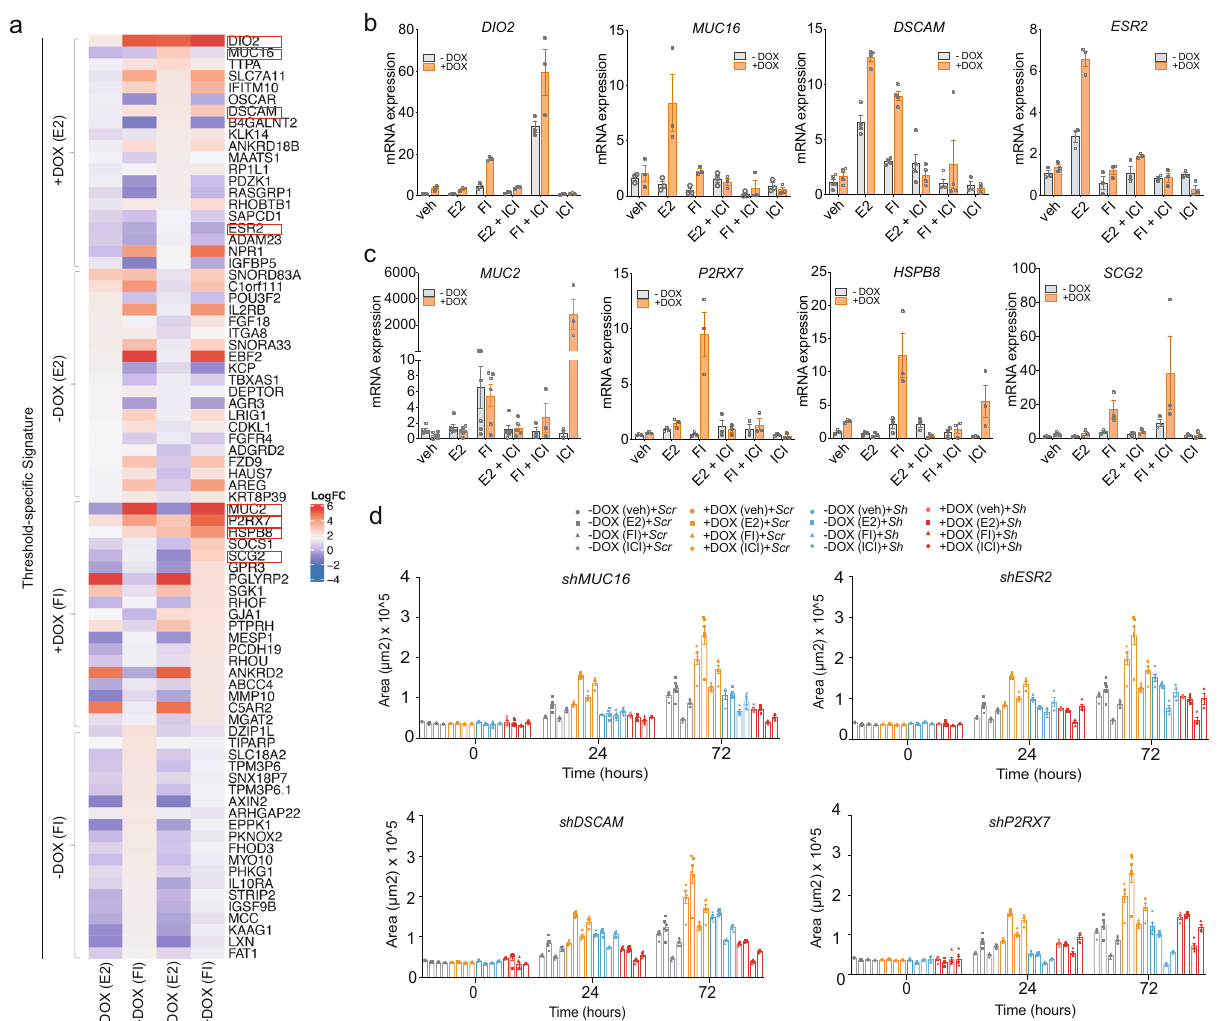
Fig. 5 ZEB1-induced new ER α target genes are implicated in the invasion. a Heatmap showing the gene expression levels of the top 20 genes from the RNA-seq data analysis, grouped to highlight treatment-speci fi c signatures (as indicated on the side). Red rectangles around gene names indicate the candidate genes selected for validation and functional assays. b , c mRNA levels of candidate genes determined by RT-qPCR (mean ± SEM, n = 3 biologically independent experiments). d Bar graphs representing the changes in the 3D invasion ability of spheroids ( n = 3 biologically independent samples, each including n = 2 replicate wells) formed from cells with ( + DOX) or without ( − DOX) ZEB1 expression upon knocking down the expression of MUC16 , ESR2 , DSCAM , and P2RX7 with the respective shRNAs. Note that the values for shScr in − DOX/ + DOX spheroids (gray and orange, respectively) are from the same data points in all graphs. veh, E2, FI, and ICI stand for vehicle, 17 β -estradiol, forskolin + IBMX, and fulvestrant, respectively. Error bars represent the standard errors of the means. All time points are shown in Supplementary Fig. 8d. Source data are provided as a Source Data fi